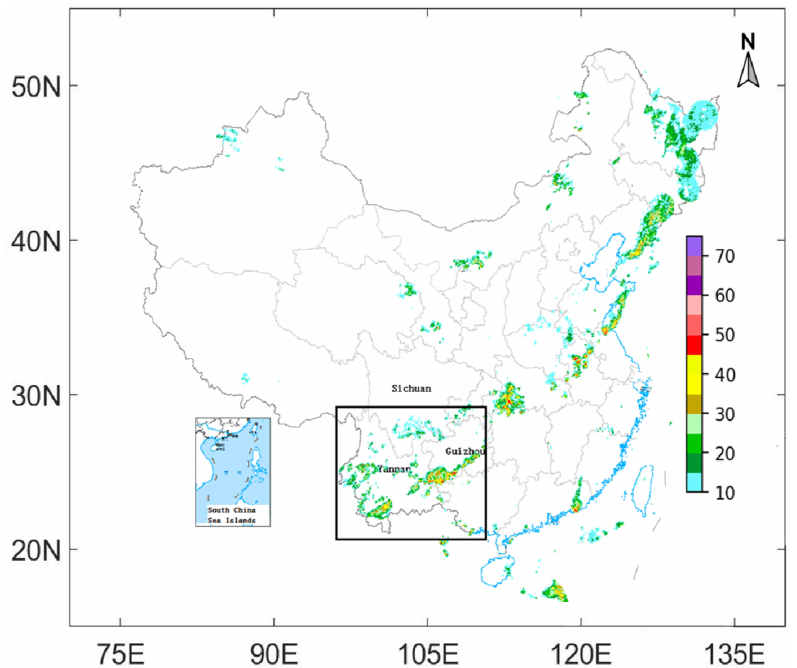
Figure 6. Doppler radar network diagram in China at 12:00 on 24 August 2020 (UTC) (color scale represents reflectance factor, unit: dBz; black box: Yunnan–Guizhou